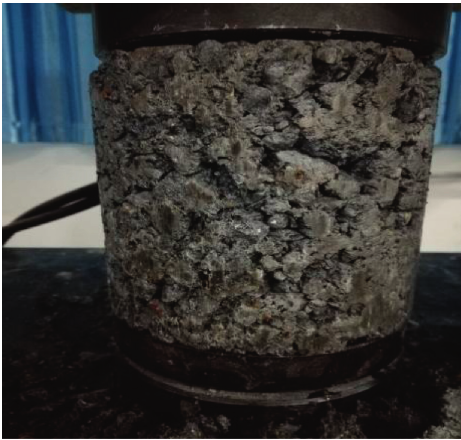
Figure 11: Compression test after freezing and thawing.